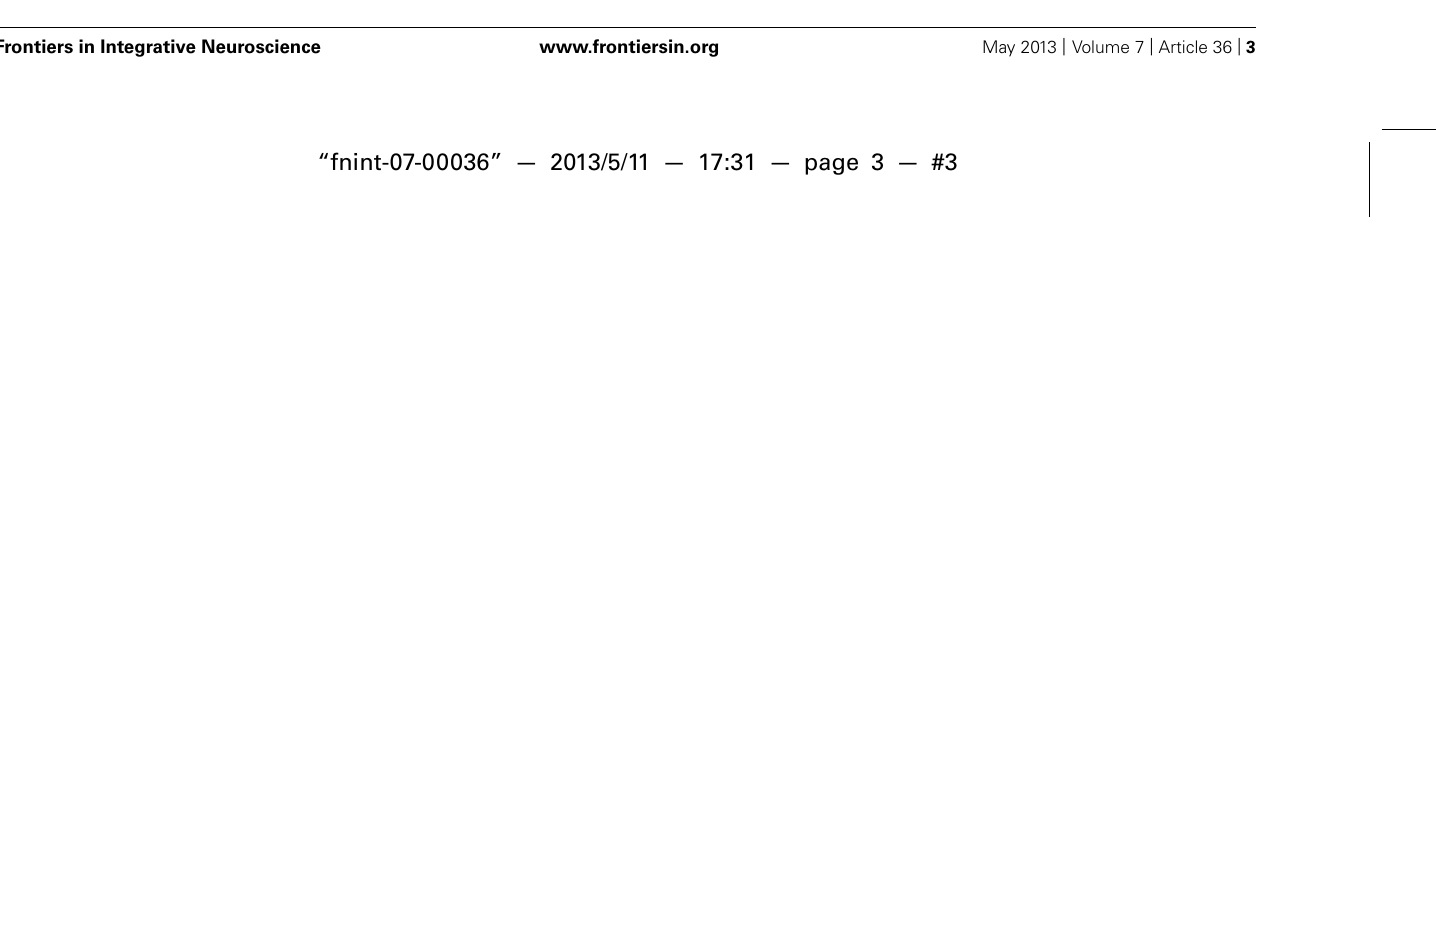
reward delivery, the shape of the FT cued the animal to expect either a large or small reward for successful completion of the trial. In the recordings from animal Ds, an uninformative small FP was shown before FT presentation. FP, fixation point; FT, fixation target; ST, saccade